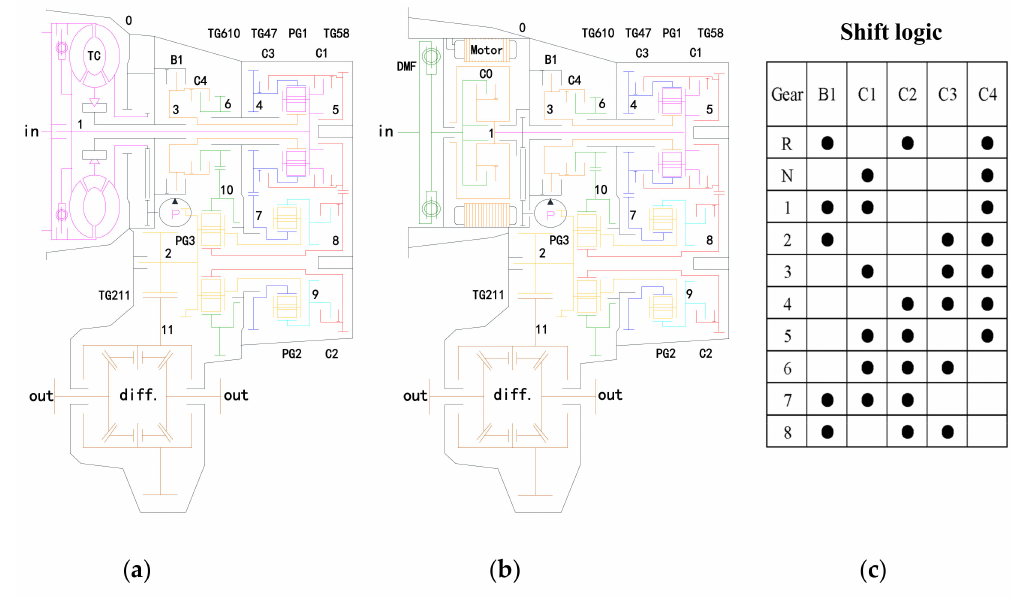
Figure 10. Schematic diagram of P2 HEVs transmission based on 8-speed AT: ( a ) Original 8-speed AT; ( b ) P2 HEVs 8-speed AT; ( c ) Shift logic of 8-speed